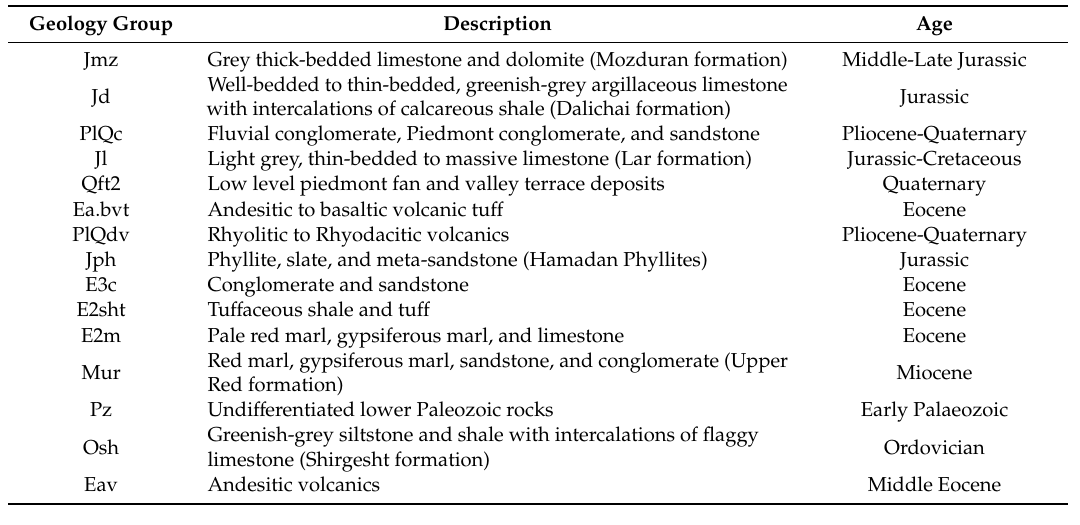
Table 2. Types of lithological formation in the Hesare-No Basin.